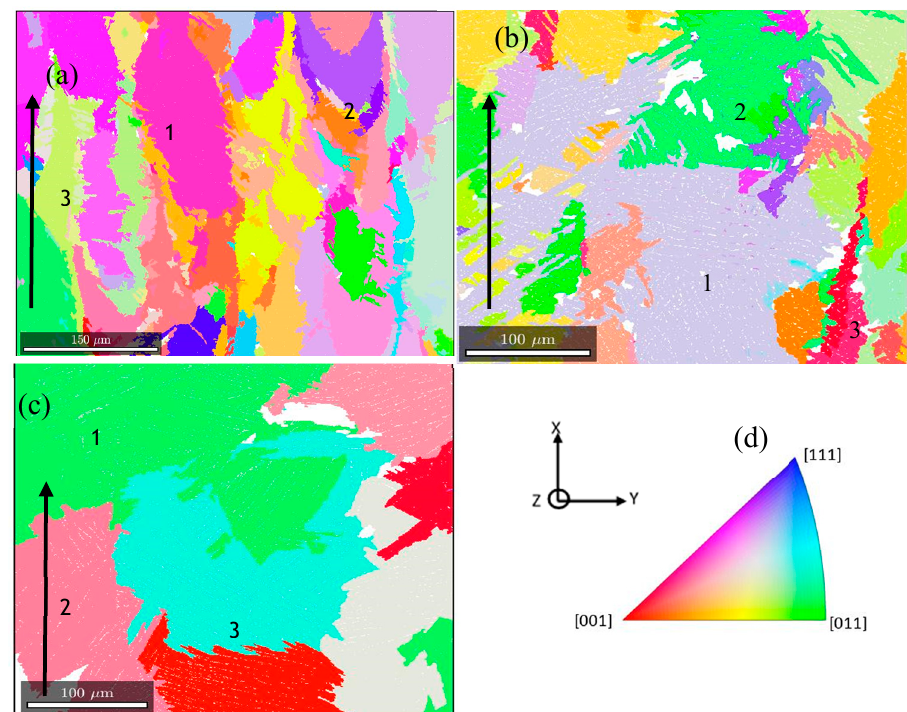
Figure 10 . Orientation maps of reconstructed β -phase of ( a ) samples A, ( b ) samples B, and ( c ) samples C, while ( d ) is the IPF key for β -bcc principle planes. The black arrows indicate the build direction.